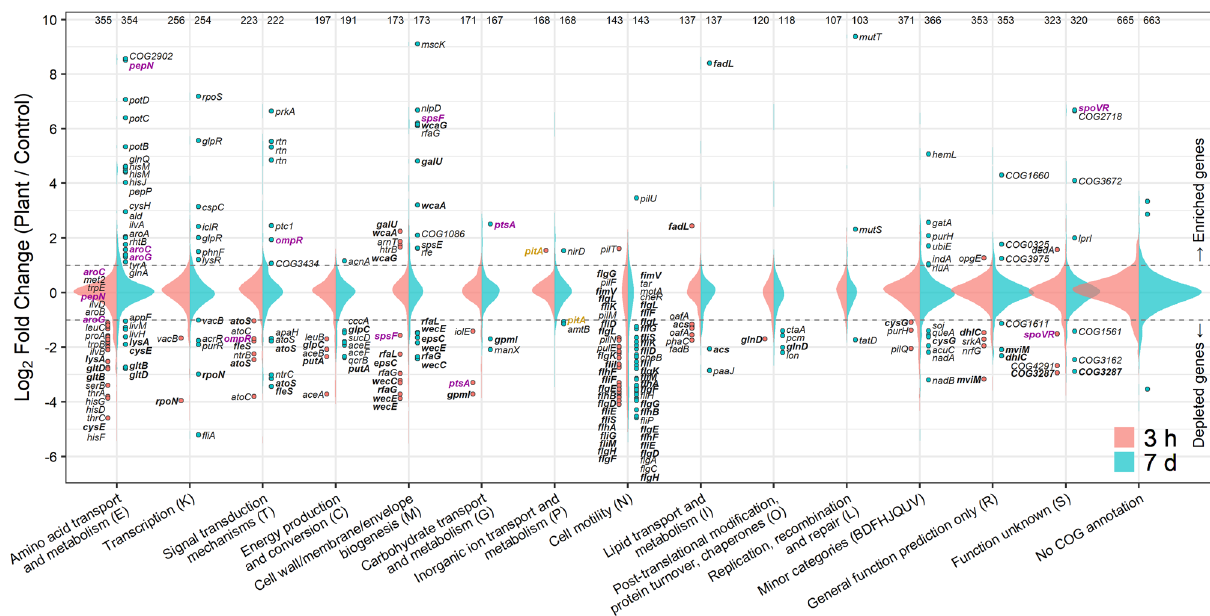
Fig. 2 Distribution of the colonization/ fi tness ability of transposon mutants. Results are shown according to functional categories based on the COG database. Depleted genes (Log 2 Plant/Control < – 1; q < 0.05) and enriched genes (Log 2 Plant/Control > 1; q < 0.05) are independently plotted. Genes that were consistently depleted or enriched across time points are shown in bold, and those with opposite results are shown in purple or yellow. Values at the top indicate the number of tested genes in each